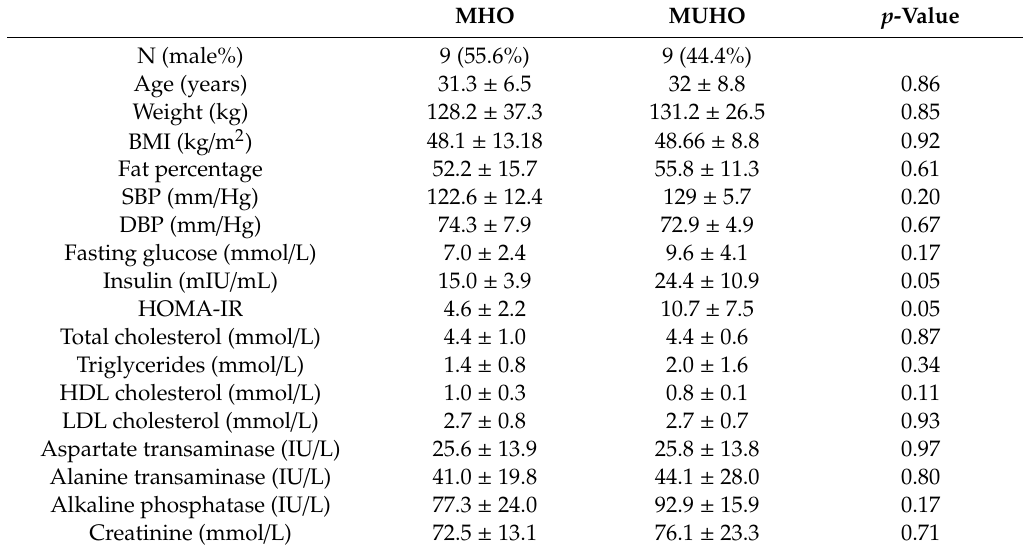
Table 1. Clinical, biochemical, metabolic, and body composition characteristics of study